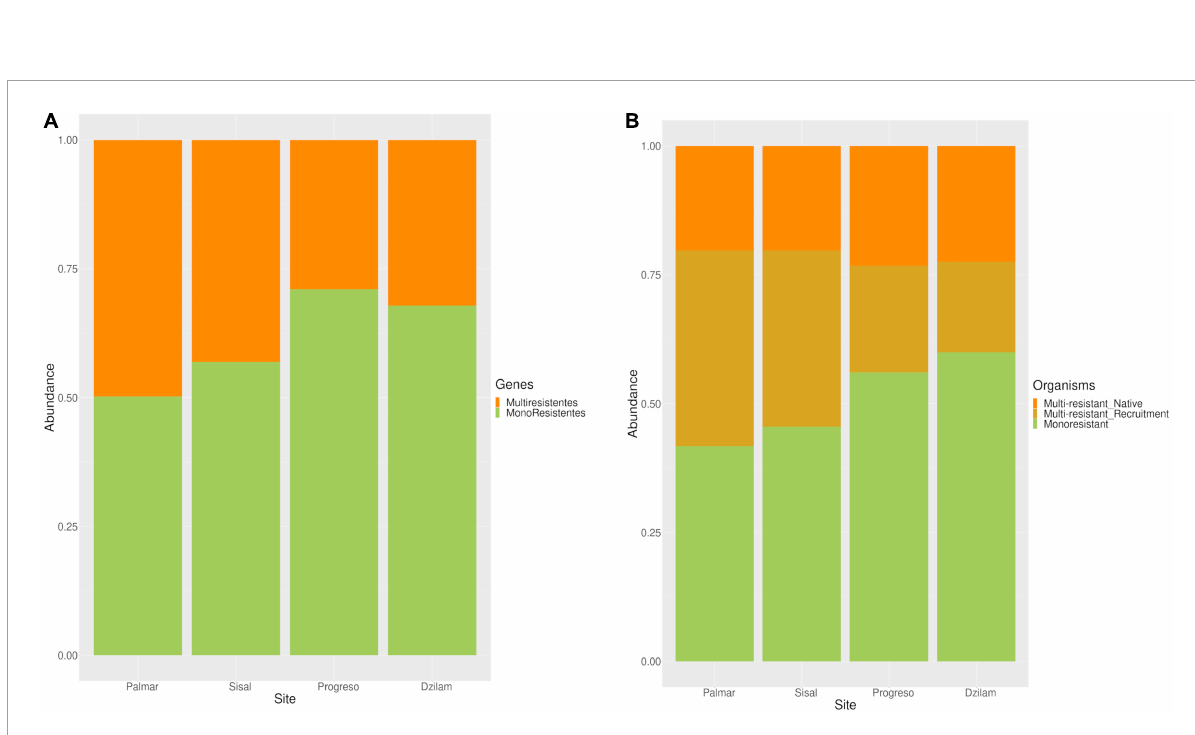
FIGURE4 Antibiotic resistance genes (ARGs) and organisms with monoresistant and multiresistant to antibiotics found on the Yucatan coast. (A) Relative abundance of ARGs monoresistant and multiresistant found in each site. (B) Relative abundance of organisms with monoresistant and multiresistant; multi-resistance in organisms was classified as native and